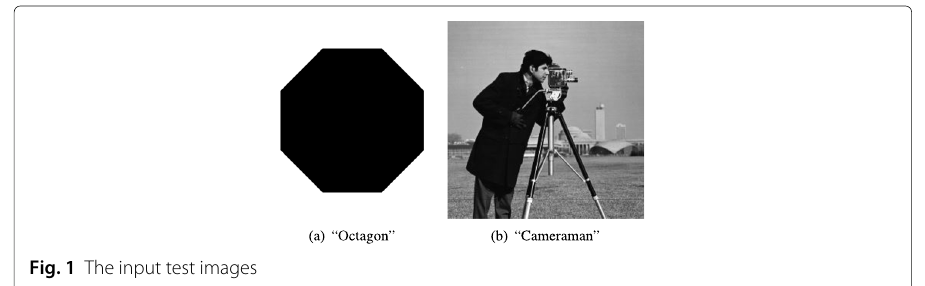
Fig. 1 The input test